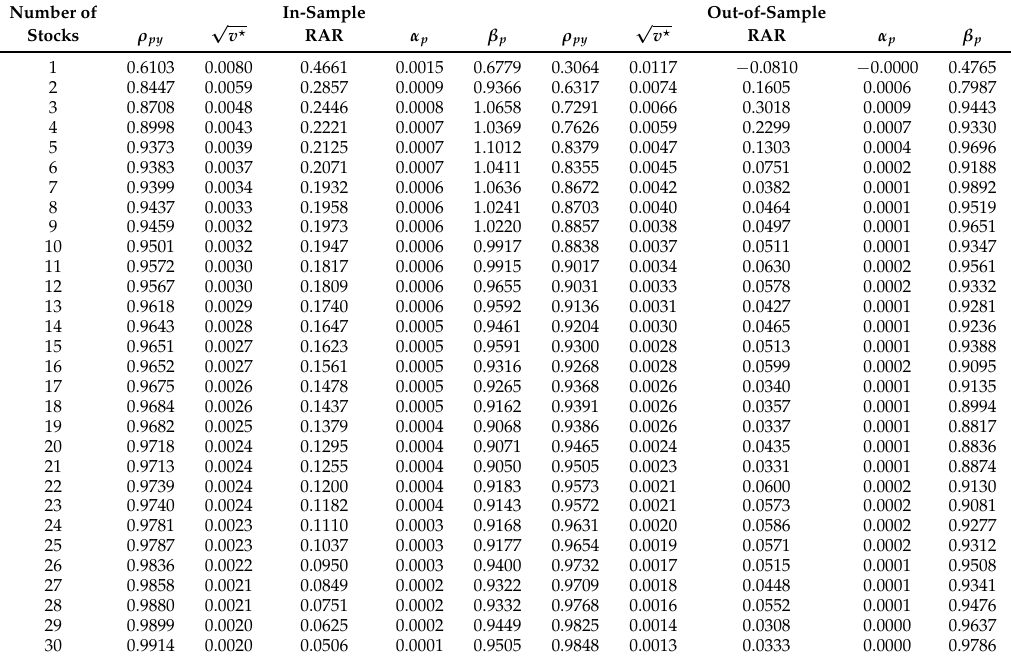
Table 5. Optimal tracking portfolios for DJIA index: Algorithm